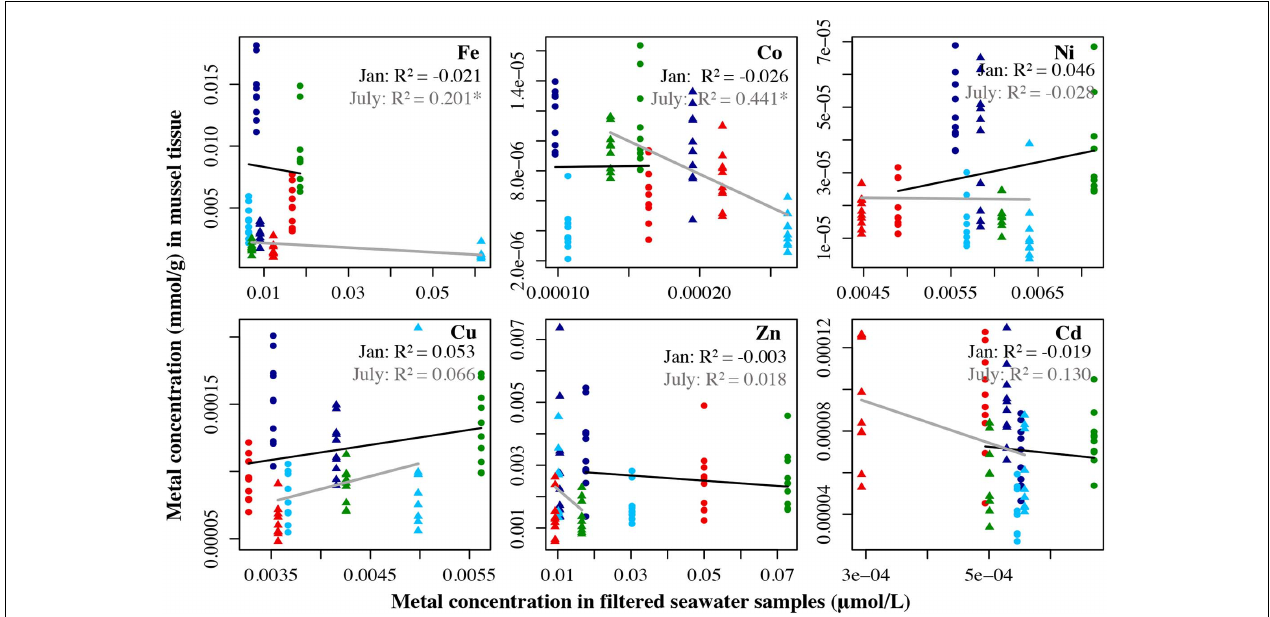
FIGURE 6 | Metal concentration ( µ mol/L) in filtered seawater samples from July 2018 and Jan 2019 plotted against the metal concentration of mussel tissue samples (mmol/g) from the four locations collected in July 2019 and Jan 2019. Circles represent the January samples, triangles represent the July samples. Dark blue = Carr Inlet 20 m, light blue = Carr Inlet 5 m, green = Point Wells 5 m, and red = Dabob Bay 5 m. Linear regression was used to assess the relationship between the two variables for January (black line) and July (gray line) separately. Asterisk indicates the adjusted the R 2 value is significant after Bonferroni correction (alpha of 0.0083).